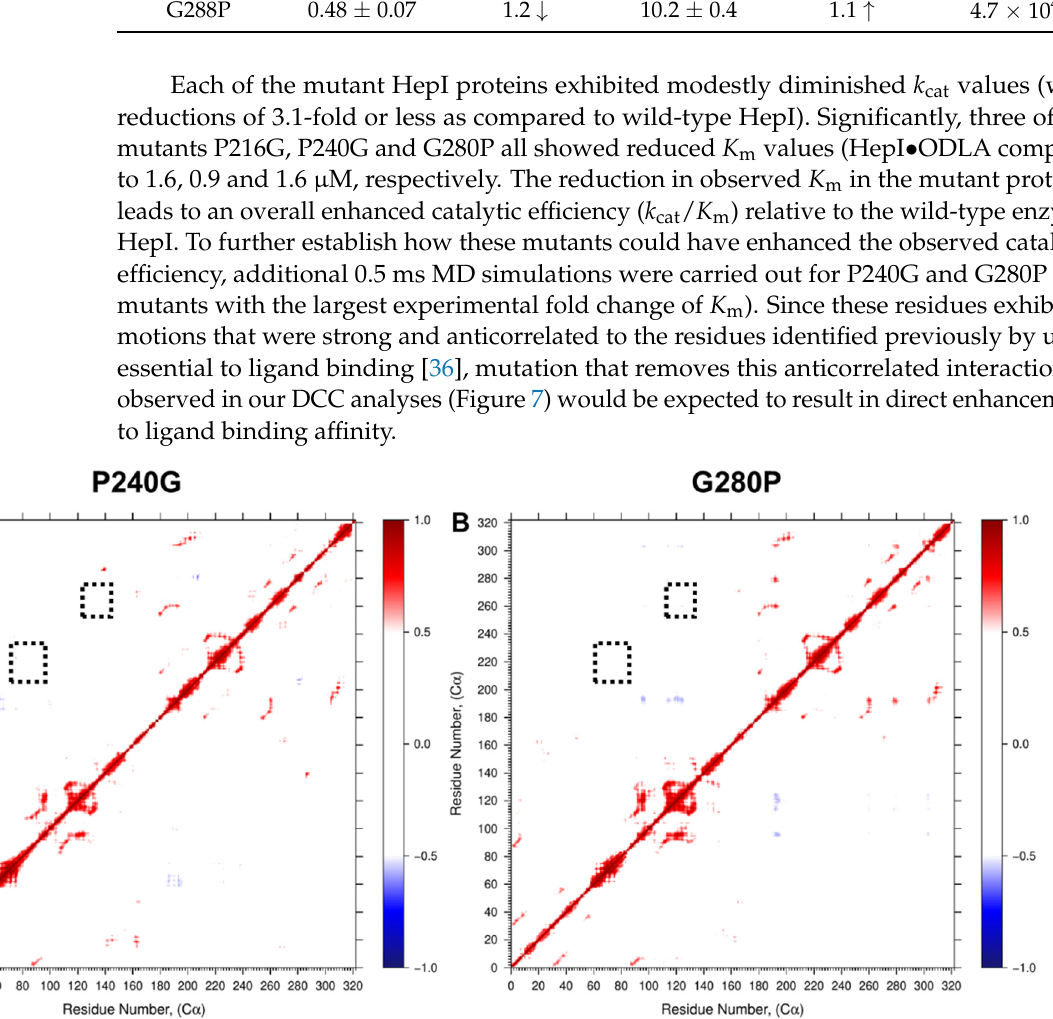
Table 1. Kinetic constants for the site-directed mutagenesis HepI.